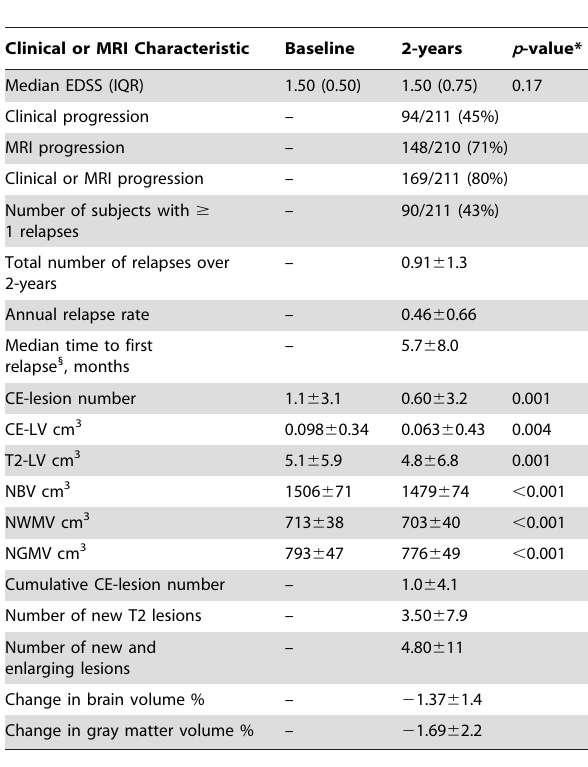
Table 2. Clinical and MRI characteristics at baseline and at 2- years.